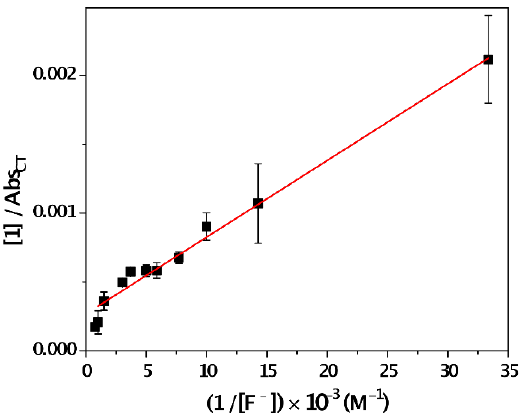
Figure 3. Benesi-Hildebrand plot used to determine the association constant of the CT complex formed by sensor 1 and F¯ (λ max = 300 nm) at different fluoride concentrations ([ 1 ] = 0.02 mM).